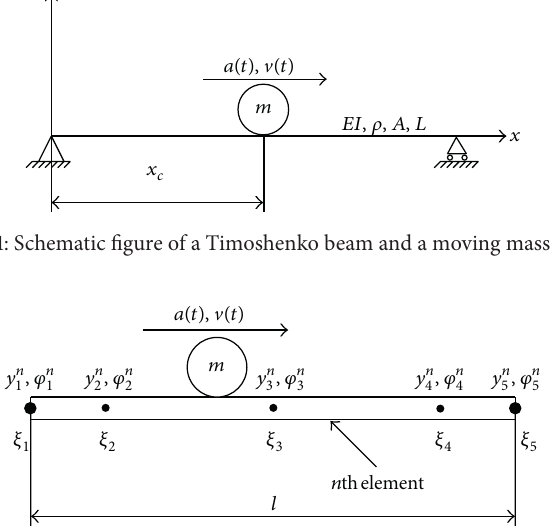
Figure 2: The 𝑛 th Timoshenko beam spectral element with an accelerating